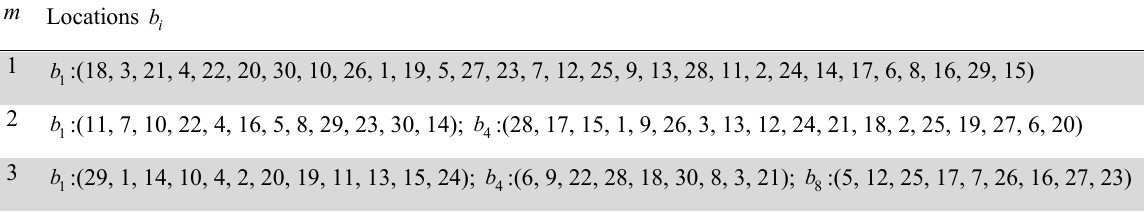
Sequences of tasks, i.e., groups of evacuated citizens for different number m of launched locations